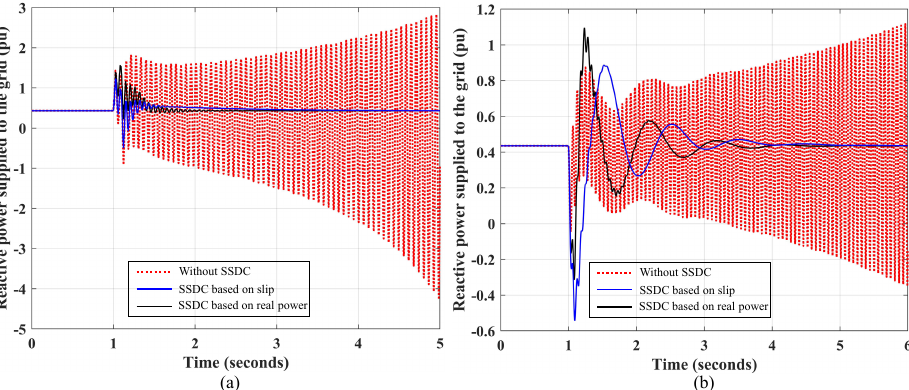
Figure 16. Reactive power delivered in response to a ( a ) grid voltage disturbance, and ( b ) grid frequency